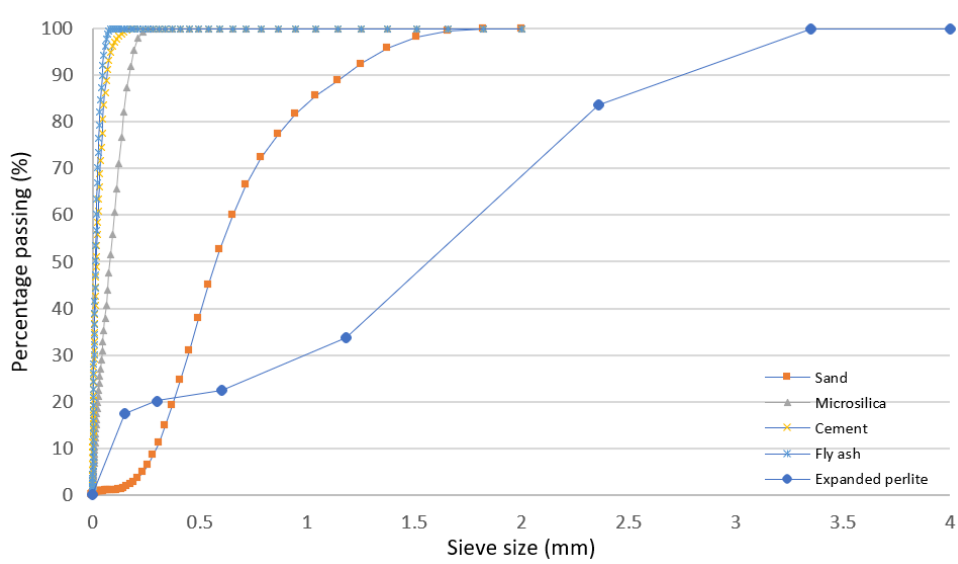
Figure 1. Grading curves of sand, microsilica, ordinary Portland cement, fly ash, and EP as a function of sieve aperture.